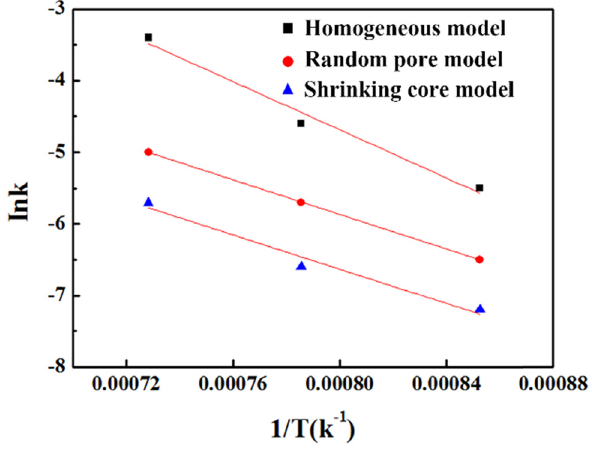
Figure 11: Fitting curves of the three kinetic